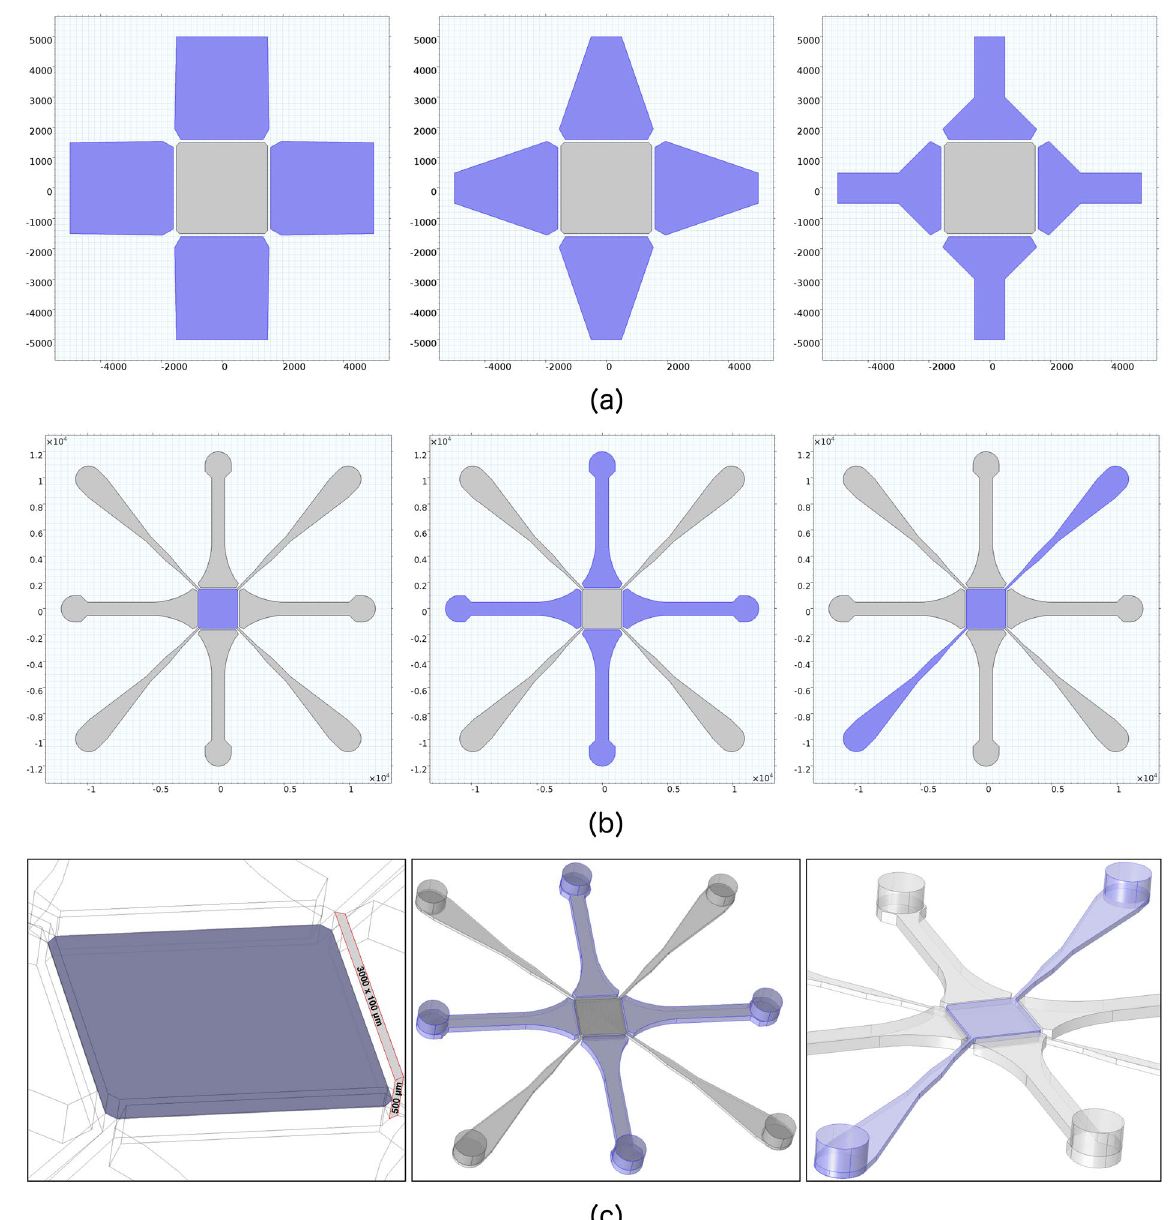
Figure 1. Key structural elements of the MCD. ( a ) Planar view of three different shape configurations for the vacuum actuators (in blue). ( b,c ) Planar view ( b ) and three-dimensional sketch ( c ) of the MCD structure. From left to right, the porous membrane (PM), the vacuum chambers (VC), and the perfusion channels (PC) are highlighted in blue colour. Length scale in [ μ m